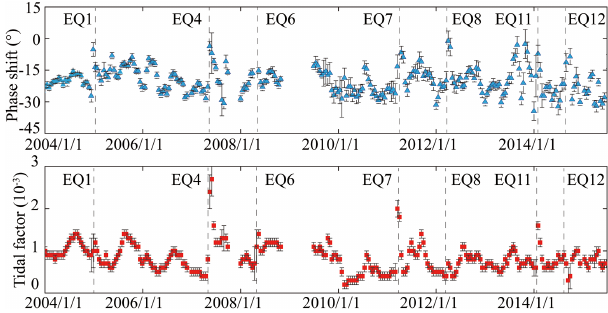
Figure 4. Phase shift and tidal factor of M 2 tidal constituent us- ing water-level observations in Dazhai well between 2004 to 2015. Vertical dashed lines indicate earthquake